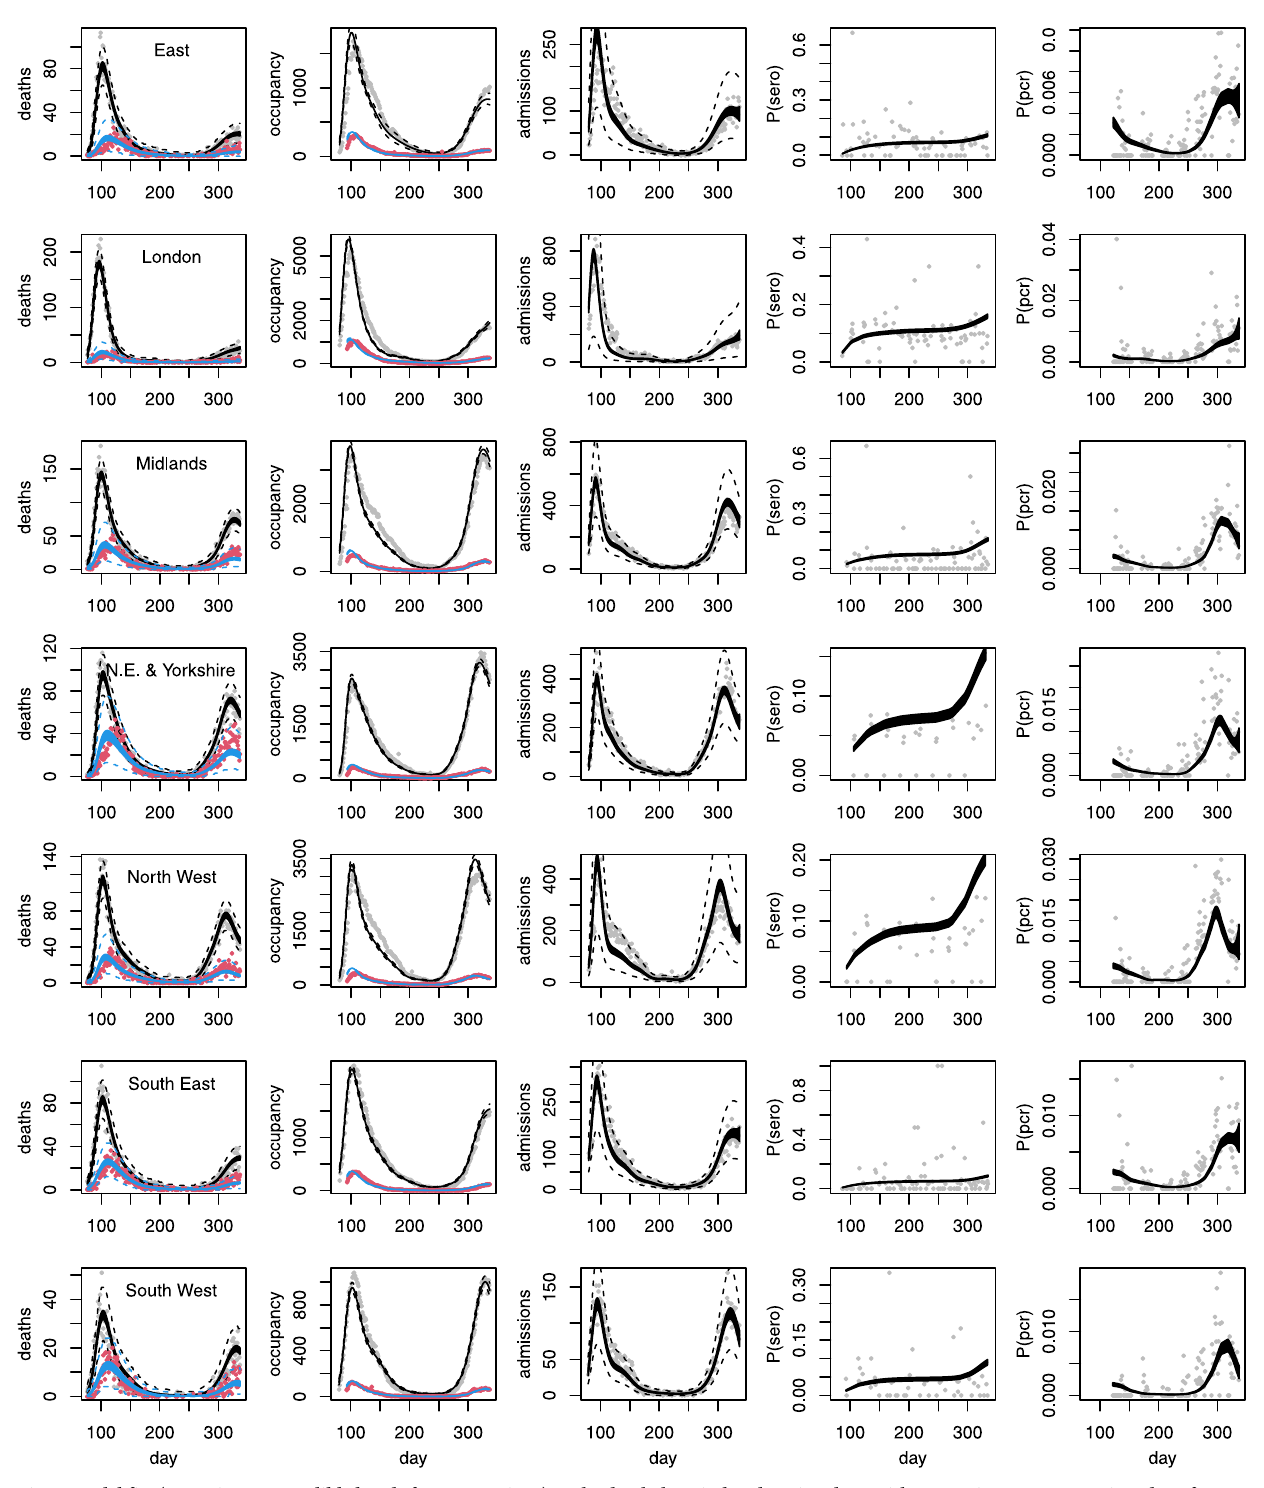
Fig 3. Model fits (posterior 95% credible bands for expectations) to the death, hospital and testing data, with one region per row, against day of year. In the leftmost ‘deaths’ column, grey points are hospital deaths and red points care home deaths. In the second ‘occupancy’ column, grey is general ward occupancy and red ICU occupancy. For the deaths and hospital admissions 95% prediction interval limits are shown as dashed curves. Prediction intervals are not reported for occupancy, where the likelihood is based on differencing, or for the test data, where highly variable sample sizes gives intervals showing no statistical problems, but which are visually unpleasant. Note some substantial discrepancies in the two northern regions.